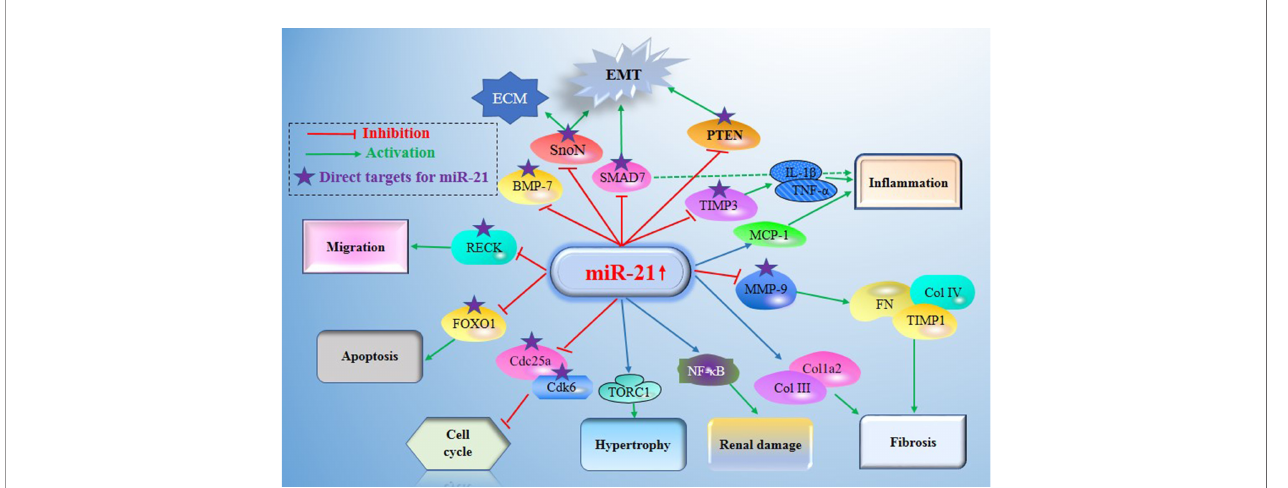
FIGURE 2 | Main mechanisms of miR21 in diabetic nephropathy (DN). miR-21 exerts its central roles in DN by constituting a complex network with the direct target genes (e.g. MMP-9, Smad7, TIMP3, Cdk6, FOXO1, IMP3, and MMP2) and the signaling cascades. DN, Diabetic nephropathy; miR-21, MicroRNA-21; TORC1, TOR complex 1; PTEN, phosphatase and tensin homolog deleted in chromosome 10; TGF- b 1, Transforming growth factor- b 1; TIMPs, tissue inhibitors of metalloproteinases; MMPs, matrix metalloproteinases; BMP-7, Bone morphogenetic protein 7; TIMP3, tissue inhibitors of metalloproteinase 3; MCP-1, monocyte chemoattractant protein 1; SnoN, Skirelated novel protein; EMT, epithelial-to-mesenchymal transition; ECM, extracellular matrix; RECK, reversion Inducing cysteine rich protein with Kazal Motifs; FOXO1, forkhead box O1; Cdc25a, Cell division cycle 25a; Cdk6, cyclindependent kinase 6; NF-Kb, nuclear factor k